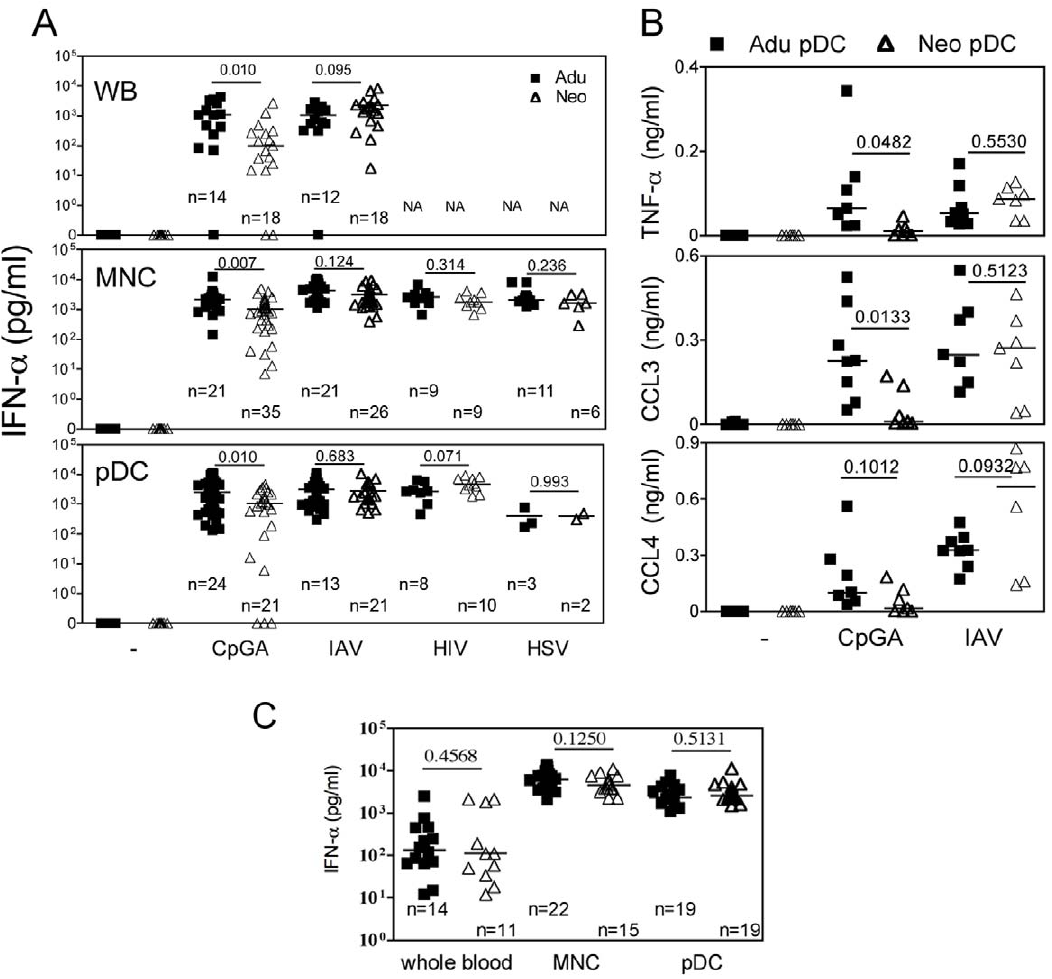
Figure 1. Innate responses of cord blood pDCs to viruses. Adult or neonatal whole blood (WB) (A and C), mononuclear cells (MNC) (A and C) or purified pDCs (A–C) were stimulated with CpGA (50 m g/ml for WB, 5 m g/ml for others in A), live IAV (1000 HAU/ml for WB, 10 HAU/ml for others), heat-inactivated IAV (HI-IAV in C) live HIV (10 5 infected T cells in A) and live HSV-1 (10 6 pfu/ml in A) for 24 hrs. Plasma or supernatants were collected and tested for IFN- a (A and C) or TNF- a , CCL3 and CCL4 (B). NA: non applicable. The number of donors is indicated for each group (n) as well as P values for adults and neonates comparison. In B, n=8 for adult and n=7 for neonates.